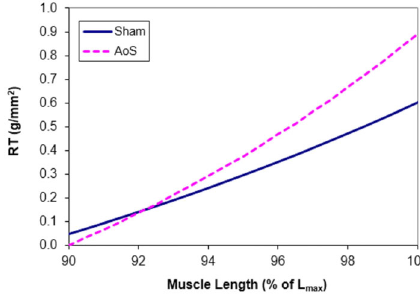
Figure 1. Relationship between muscle length variation, in % of maximum length (L max ), and resting tension (RT). P o 0.01, Sham vs aortic stenosis (AoS) (non-linear regression model adjustment using the least squares method).